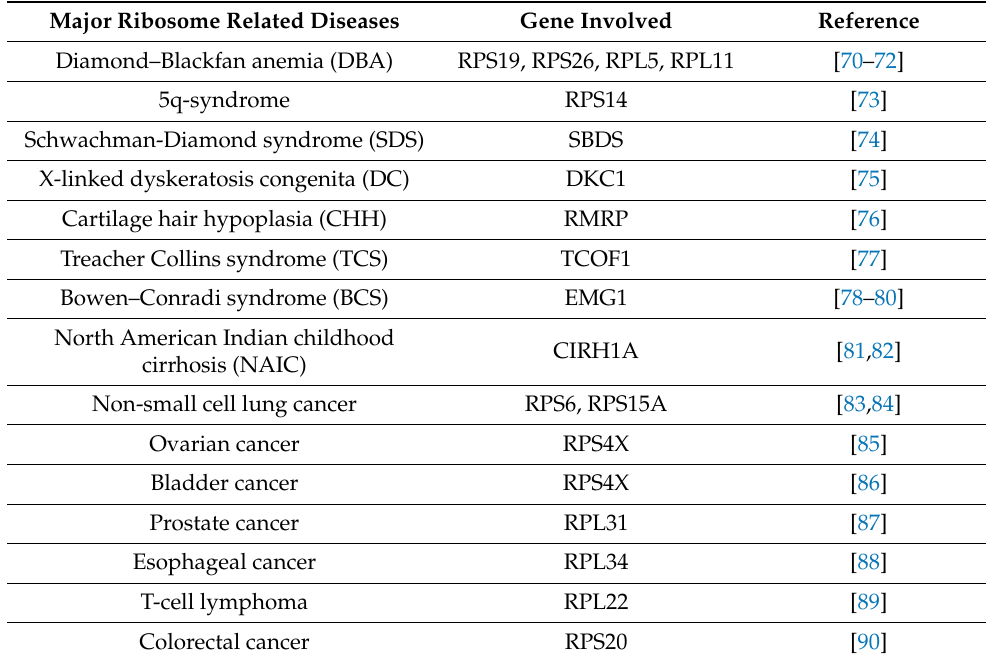
Table 3. Involvement of ribosomal proteins in different